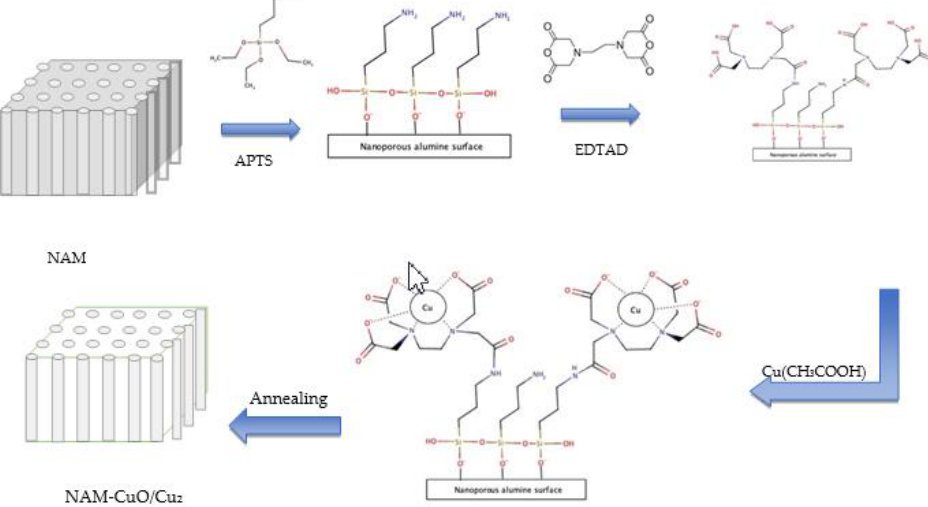
Figure 2. Schematic representation of every step of modification of hydroxylated nanoporous alu- mina membrane to produce NAM-CuO/Cu 2 O systems. membrane to produce NAM-CuO/Cu 2 O